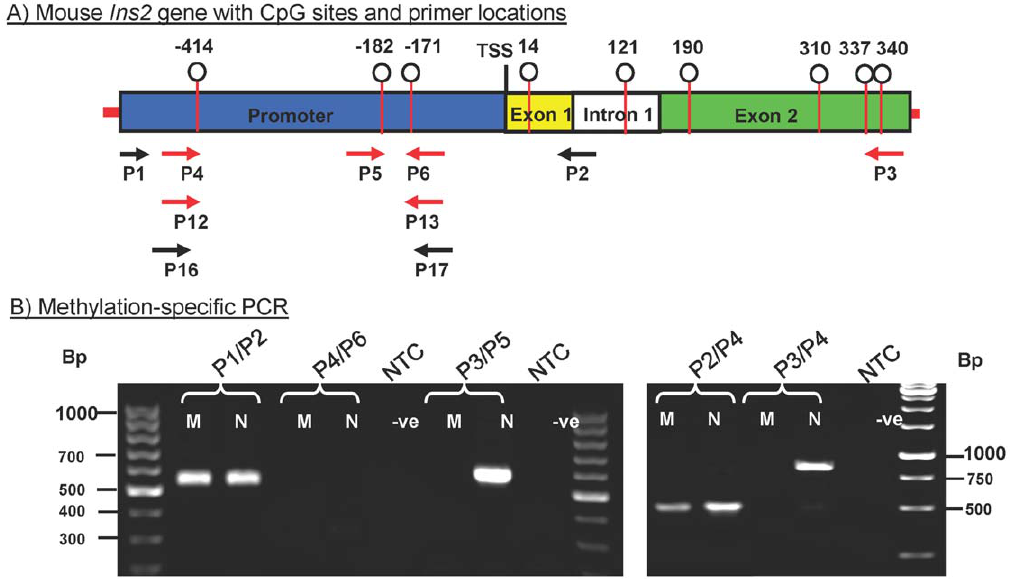
Figure 2. Rationale for selection of the primers that differentiate between methylated and unmethylated CpG. A) Schematic illustration of the mouse Ins2 gene with promoter region (blue), exon 1 (yellow), intron 1 (white), and exon 2 (green) showing the positions of CpG sites and the primers used in this study. Black arrows represent the bisulfite-specific primers (BSP) that amplify both methylated and unmethylated DNA. Red arrows represent methylation-specific primers (MSP) that amplify unmethylated but not methylated DNA. B) Gel electrophoresis (3% agarose) of PCR products amplified by reactions using different primer sets and the cloned Ins2 gene as template. The clone was methylated (M) or sham methylated (N) and bisulfite-treated prior to use in the reactions. NTC means non-template control. TSS indicates the transcription starting site.